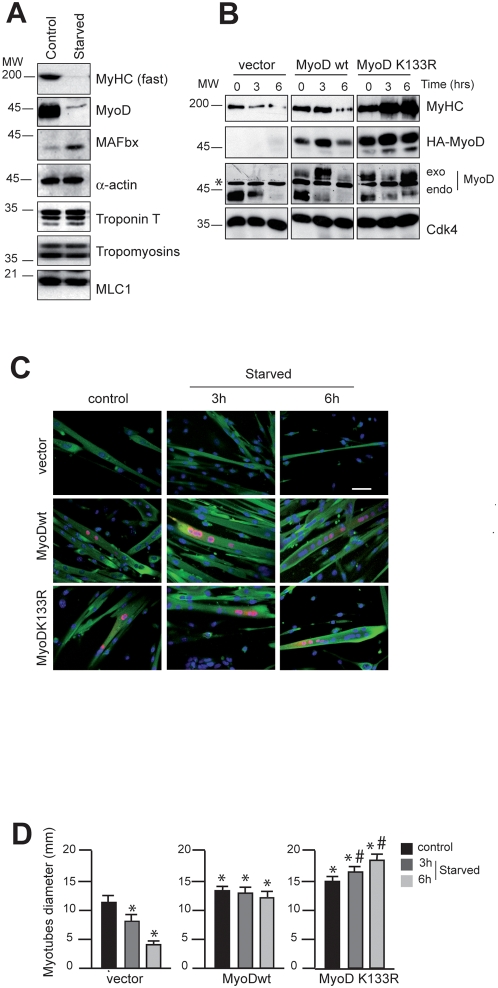
Overexpression of MyoD delays starvation-induced atrophy in primary mouse skeletal muscle myotubes.A/ Primary muscle skeletal myotubes at day 4 of differentiation were starved by removal growth medium, amino acids and glucose and were incubated in PBS for 6 h. Cell lysates were prepared and 50 µg of total proteins were subjected to Western blot analysis to probe for MAFbx, MyoD and myofibrillar proteins. B/ Primary culture of satellite cells were transfected with the expression vector encoding HA-MyoDwt and/or the mutant HA-MyoD K133R as indicated. Twenty-four hours later, cells were homogenized, and at confluence, cells were placed in differentiation medium. Myotubes at day 4 of differentiation were harvested at various times as indicated. Cell lysates were prepared and 50 µg of total proteins were subjected to Western blot with anti–HA antibodies, anti-MyoD antibodies, anti-MyHC antibodies and anti-Cdk4 antibodies as internal control of loading. C/ Myotubes were stained with Hoechst 33258 to visualize the nuclei and with anti-HA antibodies to detect exogenous MyoD expression protein (red) and anti-MyHC antibodies (green) respectively. Images of a representative field were obtained by light microscopy (Scale bar 100 µm). D/ Myotubes diameter after MyoD overexpression in normal and atrophic medium. Experiments were repeated three times with similar results. Data represent the average ±s.e. of at least 150 myotubes. *P<0.05 between control and MyoDwt or MyoD K133R overexpressing cells, #
P<0.05 between MyoDwt and MyoD K133R.